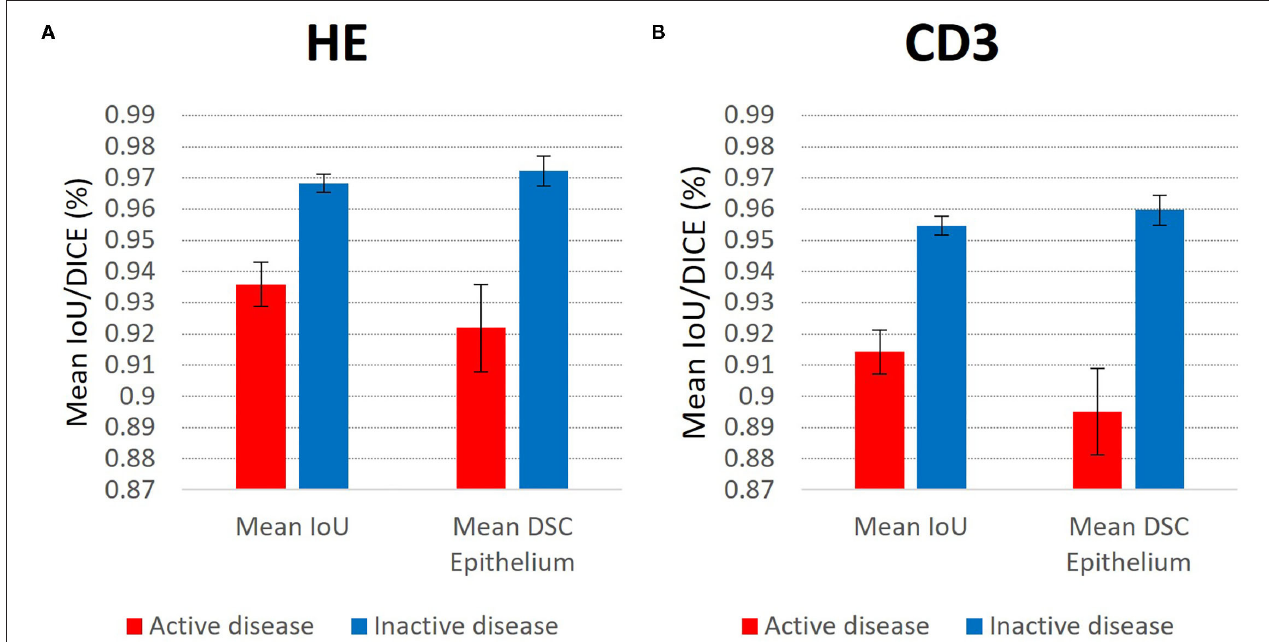
FIGURE 4 | Significant differences in prediction accuracies for the (A) HE stained test set WSIs ( n = 36) with active disease ( n = 15) vs. inactive disease ( n = 21), and (B) CD3 immunostained test set WSIs ( n = 21) with active disease ( n = 7) and inactive disease ( n = 14). Error bars represent 95% confidence intervals assuming normality. Two-tailed Student’s T -test of active vs. inactive disease gave p < 0.0001 for all four